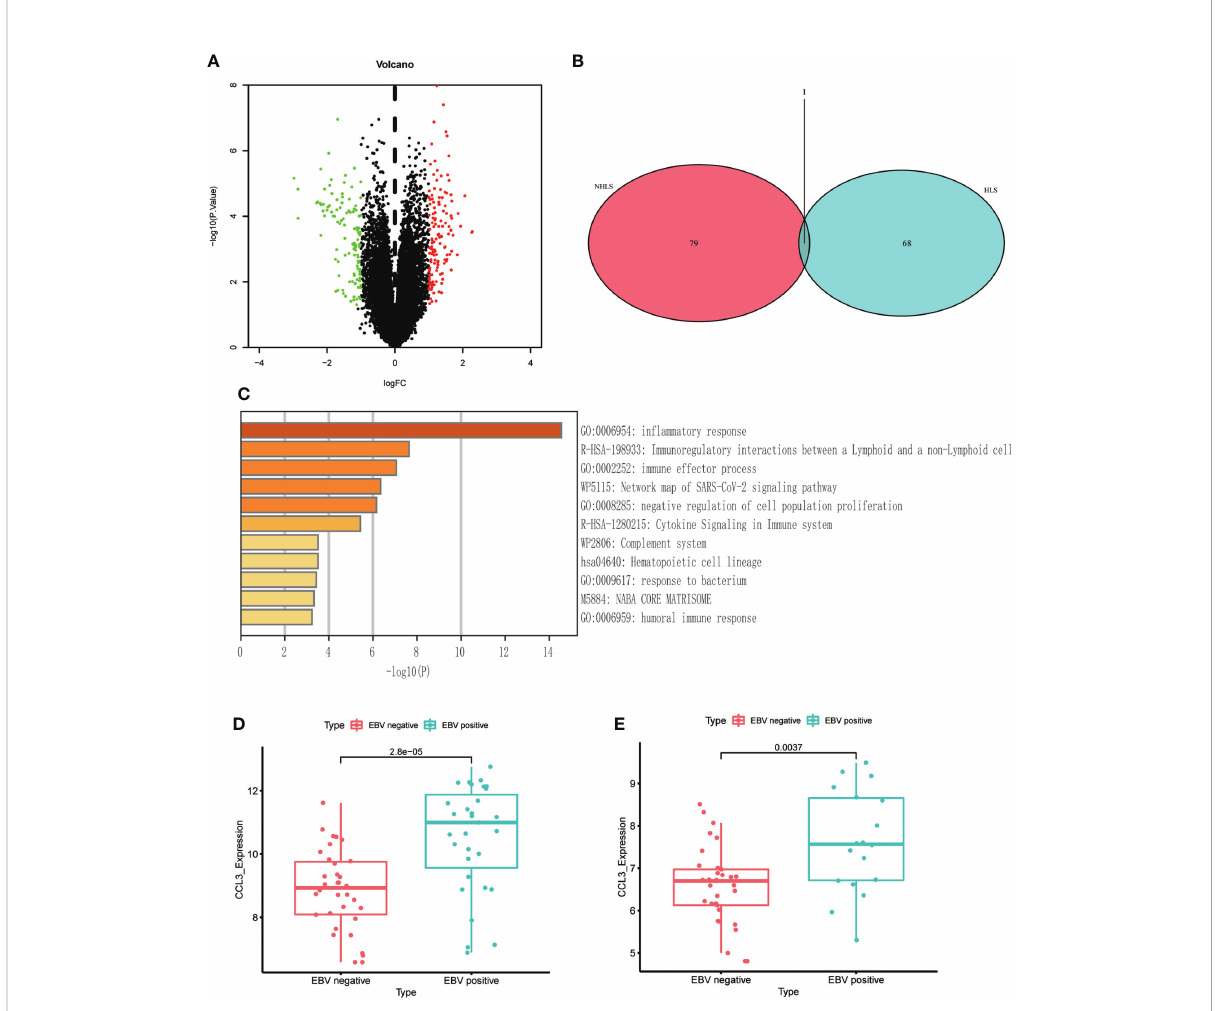
FIGURE 2 The differential genes between EBV+ and EBV- lymphoma samples. (A) Volcano plot of differential genes in EBV- and EBV+ lymphoma groups. (B) Venn diagram of overlapping differentially expressed genes in GSE38885 and GSE13996 datasets. (C) Functional enrichment of differential genes bases on Metascape database. (D) The box plot shows the expression level of CCL3 between two groups in NHLs. (E) The box plot shows the expression level of CCL3 between two groups in